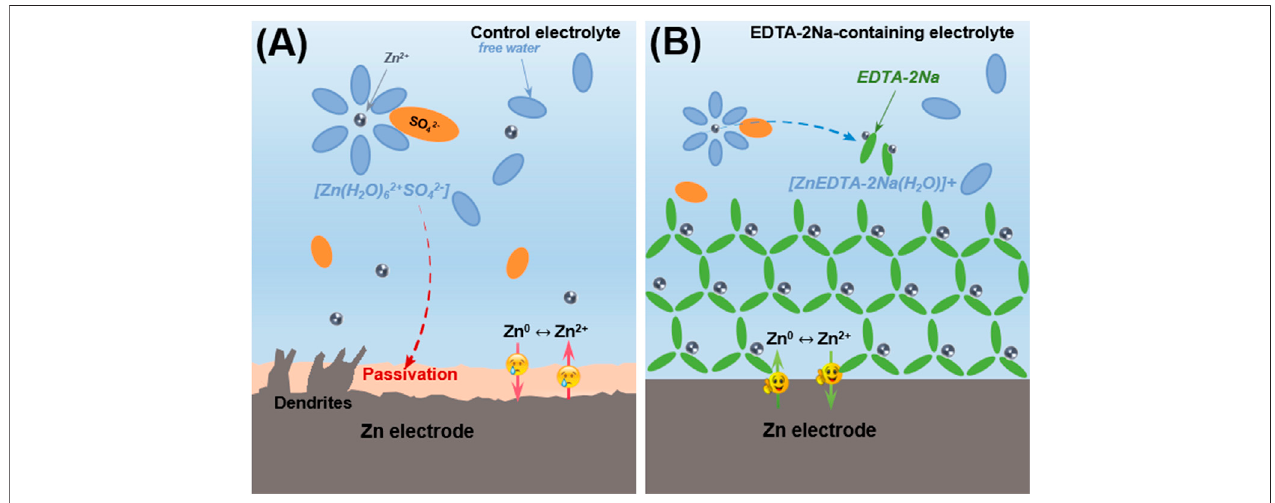
FIGURE1| Schematic illustration ofZnsurfaceevolution. (A) Stubborn insulateddepositionand dendrite formationcaused byattack fromdesolvationprocesson Zn foil. (B) Function mechanism of EDTA-2Na chelating agent to eliminate deposition and forms a stable chelating state in aqueous electrolyte.